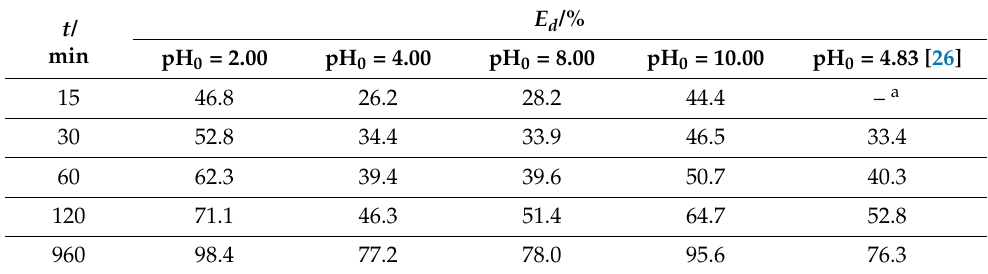
Table 2. Efficiency of decolouration ( E d ) after appropriate time of adsorption ( t ) for different initial pH 0